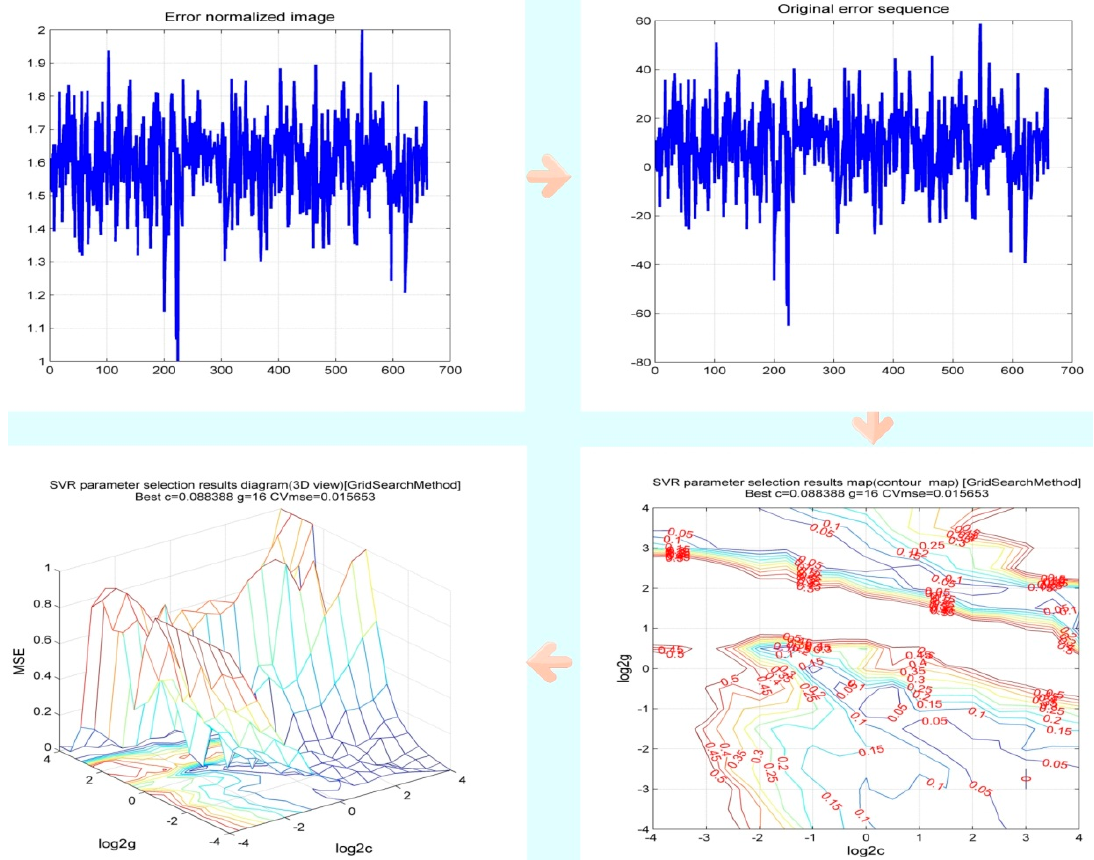
Figure 7. SVM error correction chart.